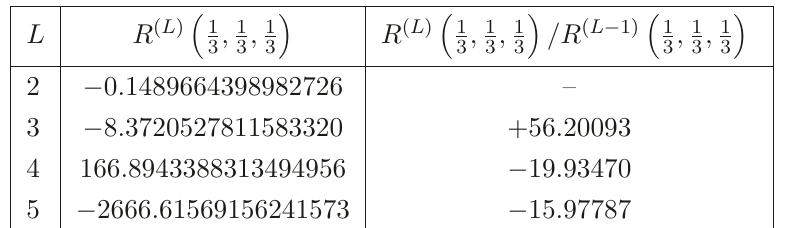
1 , 1 , 1 3 3 3 (cid:0) (cid:1)